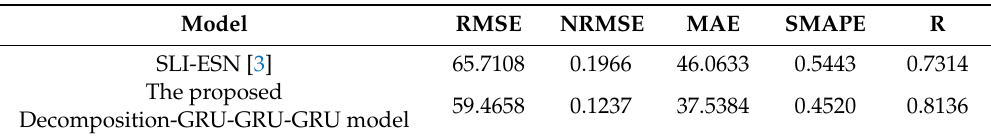
Table 2. Comparison of 10-step (10 h) prediction